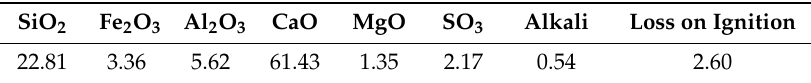
Table 1. Chemical composition of ordinary Portland cement (%).